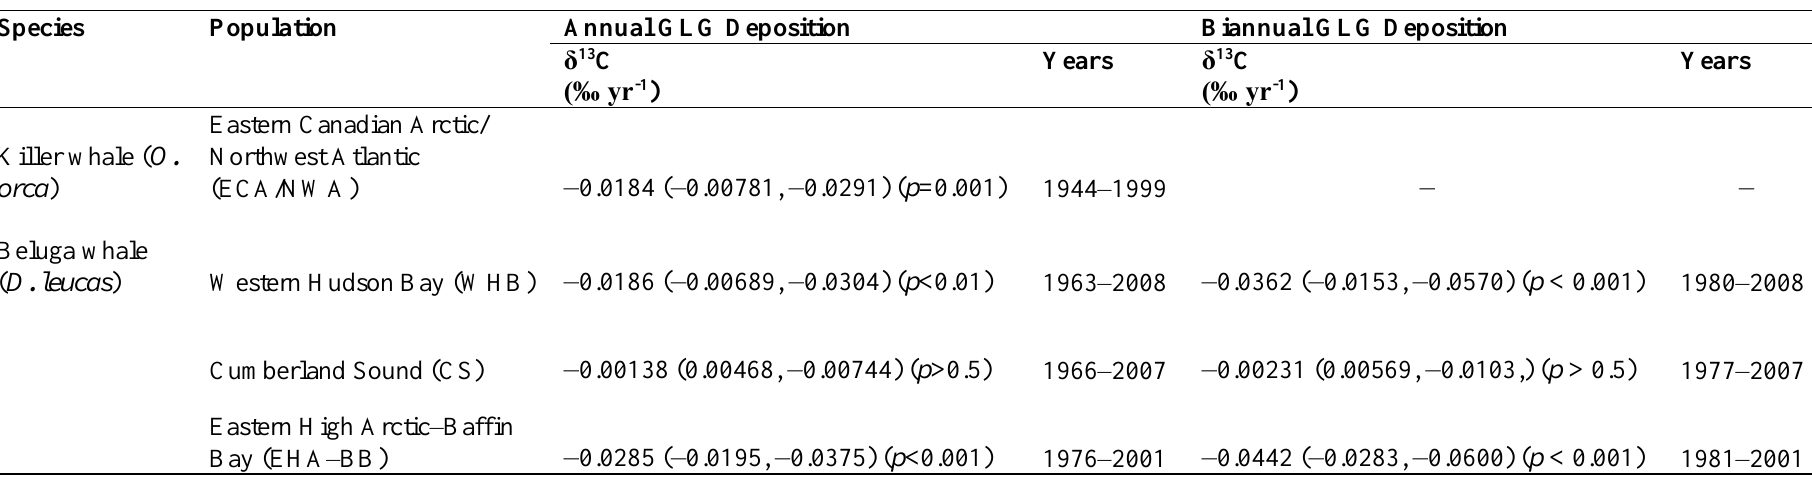
Table 1. Rates of δ 13 C declines across dentinal GLGs of killer whales (1944–1999) and beluga (1960s–2000s) in the eastern Canadian Arctic/North Atlantic. 95 % confidence intervals in